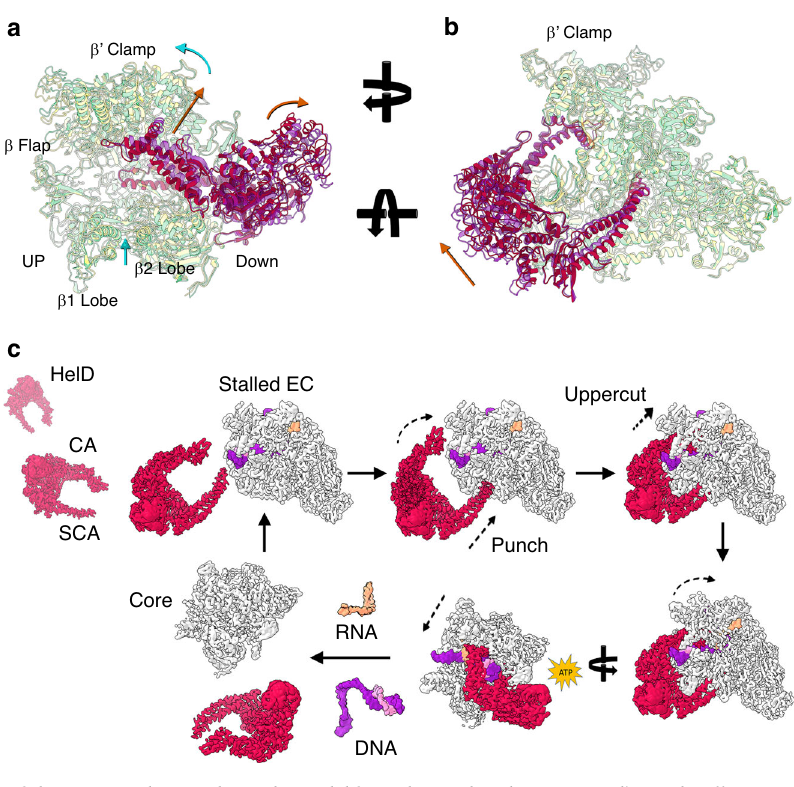
Fig. 6 3D variability analysis of the RNAP – HelD complex and a model for HelD-catalysed RNAP recycling. a , b Different orientations of the most distinct conformations determined by 3DVA. HelD is shown in solid colours with RNAP semi-transparent. The red conformation of HelD is matched to the pale green conformation of RNAP, and the purple HelD with the yellow RNAP. Orange arrows indicate the movement of the juxtaposed region of HelD, and cyan arrows regions of RNAP. Structural elements of RNAP referred to in the text are labelled as well as the up- (UP) and downstream (DOWN) sides of RNAP. c Model for HelD-catalysed recycling. HelD is shown in red, RNAP in white, DNA in purple (template) and pink (non-template), and RNA in orange. Clockwise from top left; HelD locates a stalled EC and binds with the SCA penetrating the secondary channel and the CA moving into position on the β ’ clamp. The SCA is wedged deep within RNAP, and through conserved interactions with the 1 A torso domain, locks HelD in position. The contacts the CA makes with the β ’ clamp, open the DNA-binding and RNA-exit channels to enable dissociation of nucleic acids from the EC, possibly assisted by interaction of the DNA with the positively-charged patch on the CA of HelD. HelD (and nucleic acid) dissociation is facilitated by the conformational changes facilitated by ATP binding/hydrolysis (ATP fl ash). Finally, core RNAP that has been released from the complex is free to enter a fresh round of